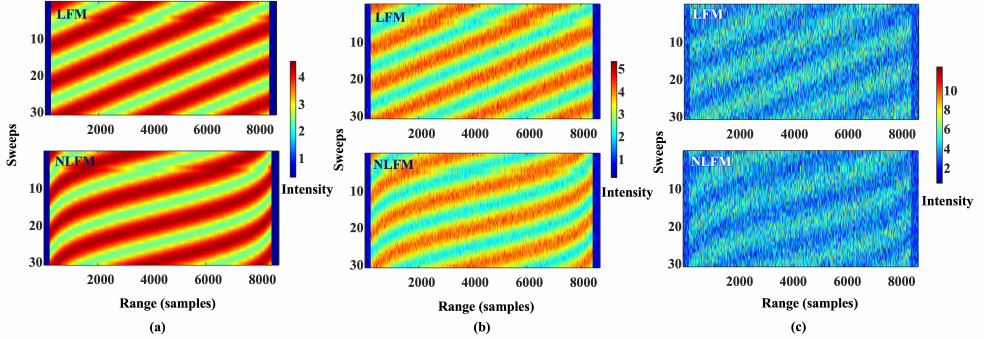
Figure 7. Raw data at different SNRs . ( a ) 30 dB. ( b ) 15 dB, and ( c ) 0 dB,